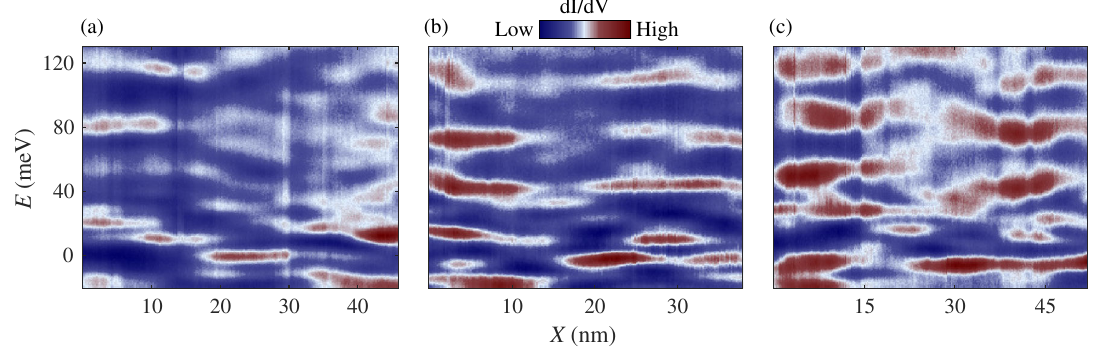
FIG. 14. Quantized resonances in different terraces. Panels (a) – (c) show the dI/dV maps from three different terraces, averaged over 12 line cuts across the nanowire ( Y ). A smooth background has been subtracted for visibility. The observed puddles are the quantized resonances used to determine the lifetime of the states.